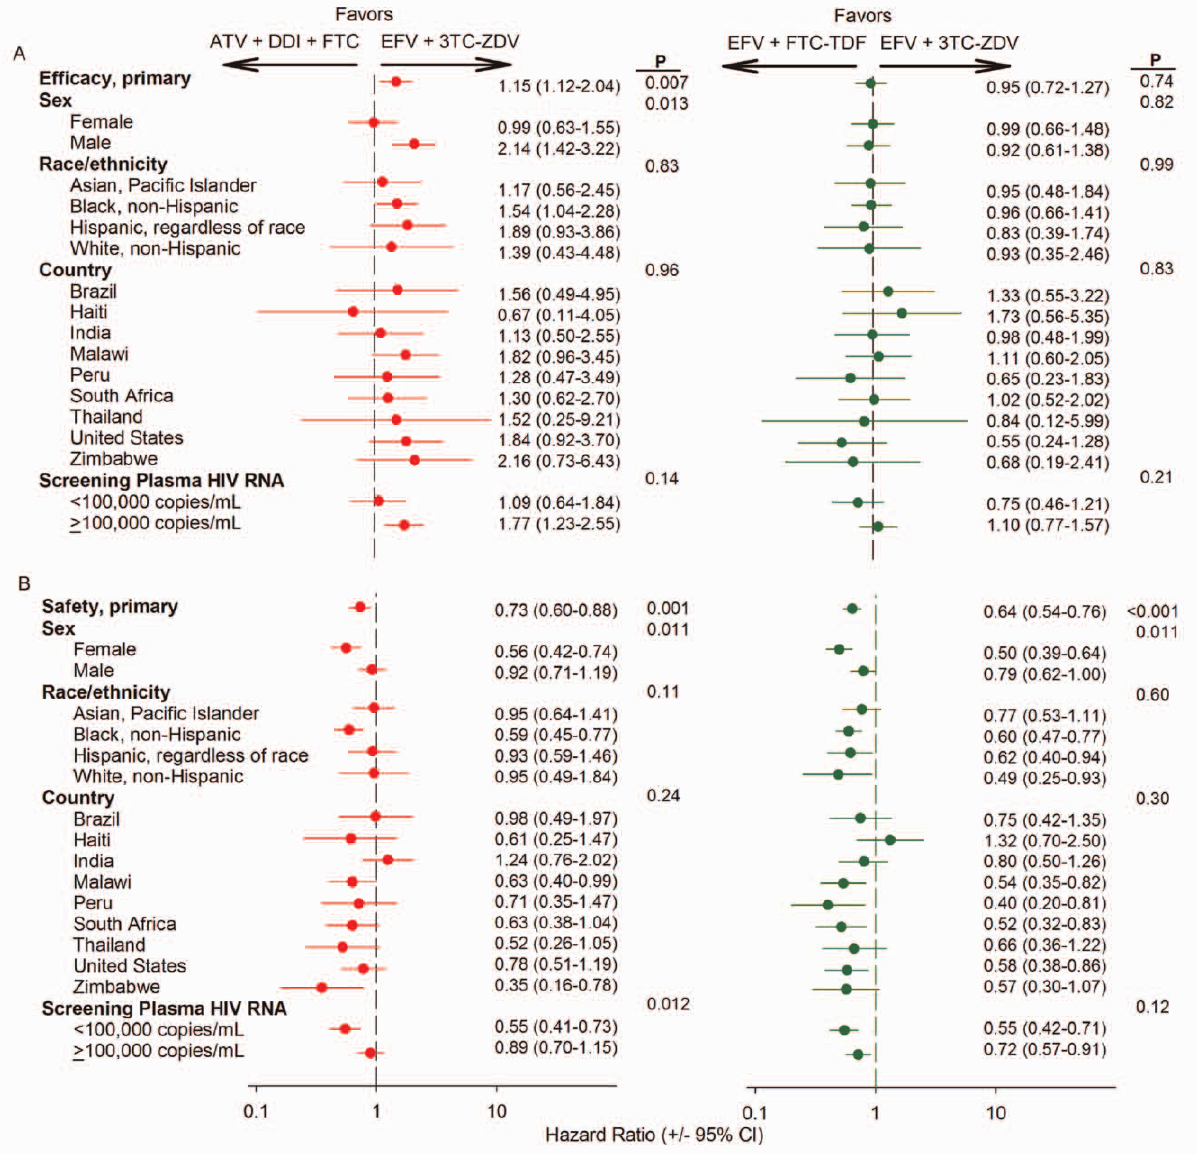
Figure 3. Subgroup analysis for primary efficacy and safety endpoints by randomly assigned antiretroviral treatment. Subgroup analyses were conducted for the baseline covariates self-reported sex and race/ethnicity and the countries in which the participating research sites were located. The relative risk and 95% CIs are provided for all participants (overall) and for each subgroup. p -Value represents interaction test between baseline covariate and randomized treatment group. Comparisons between ATV plus DDI and FTC and EFV plus 3TC-ZDV are in red. Comparisons between EFV plus FTC-TDF and EFV plus 3TC-ZDV are in green. (A) Treatment failure (efficacy) composite endpoint. (B) Safety events composite endpoint.